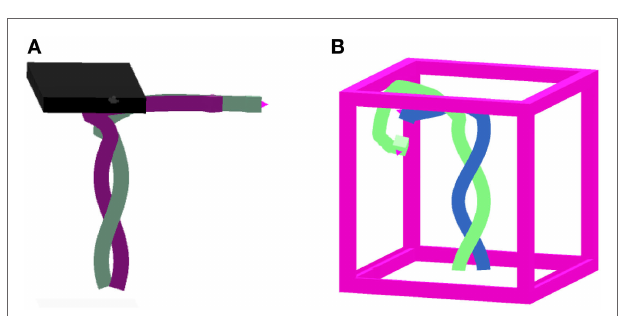
FigUre 12 | (a) The SG braid agents react to their physical environment and deflect from a plate. (B) Two SG braid agents are trapped inside a braiding volume which can be used to guide their evolution (Wagner et al., 2017).